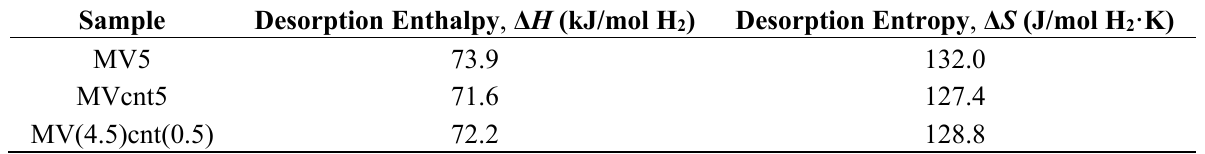
Table 2. Thermodynamic properties of various